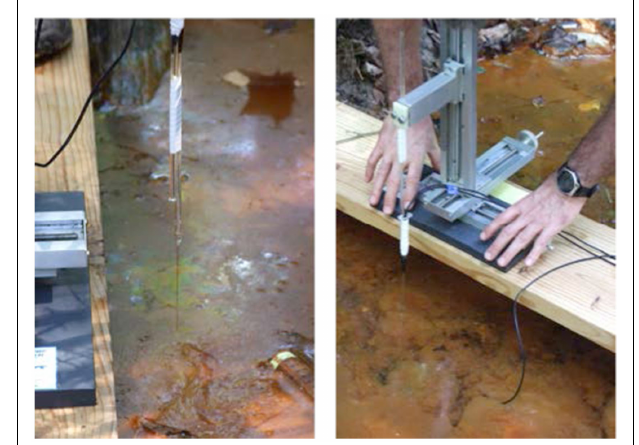
FIGURE 3 | Photos of voltammetric microelectrode deployment in the microbial mat (left) and the puffball (right). The microbial mat was essentially on the surface, whereas the puffball was overlain by about 10cm of